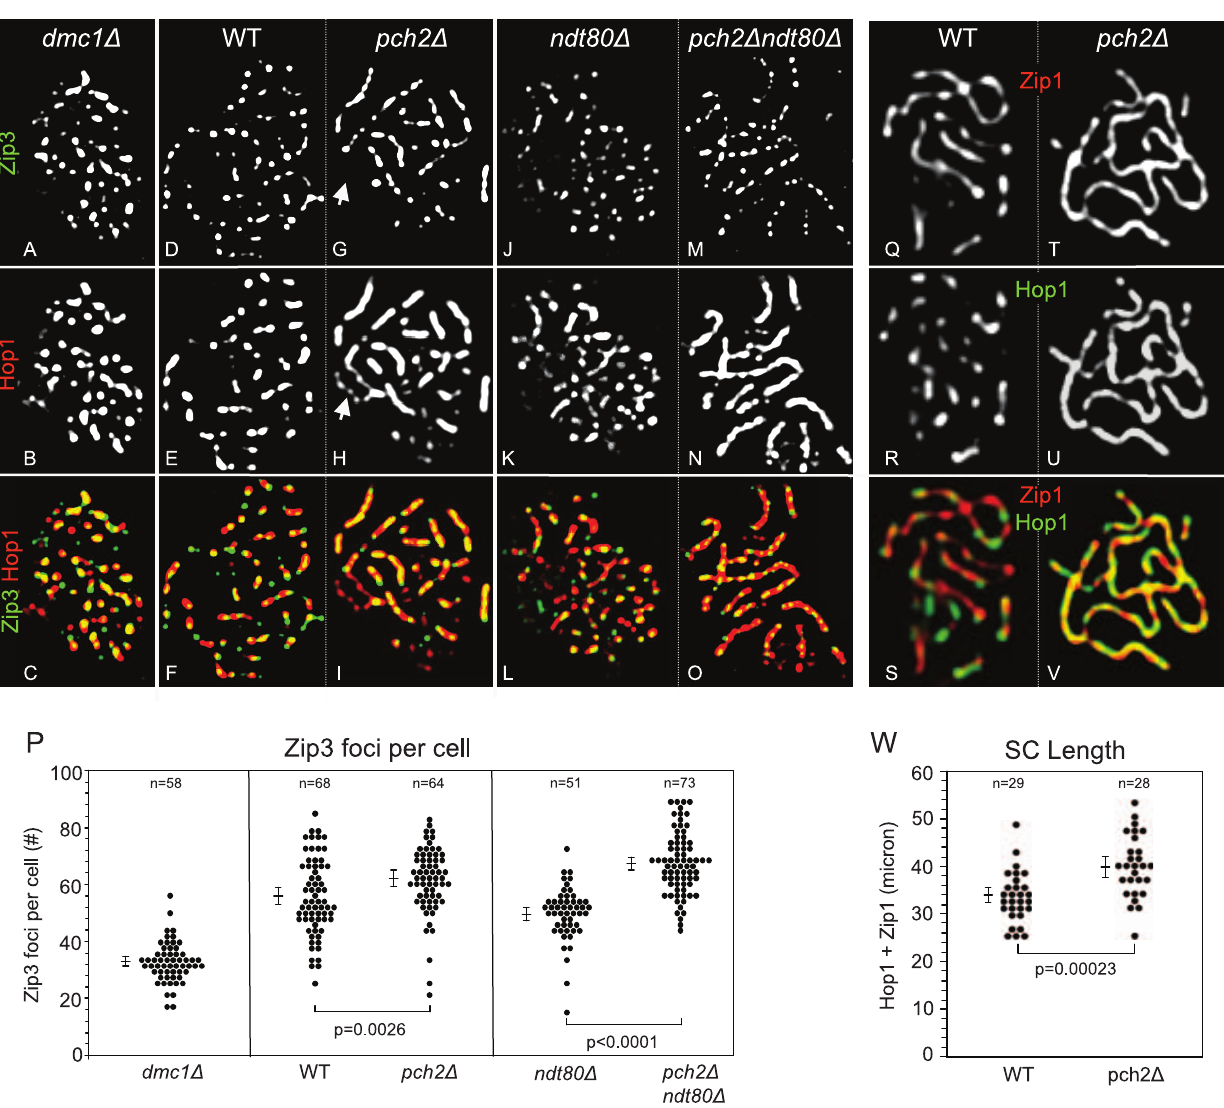
Figure 4. Effects of Dmc1, Pch2, and Ndt80 on Zip3 and Hop1 localization and SC length in WT and pch2 D . (A–P) Spread nuclei from dmc1 D (A–C), WT ( PCH2 ) (D–F), pch2 D (G–I), PCH2ndt80 D (J–L), pch2 D ndt80 D (M–O) were stained with antibodies against Hop1 and Zip3. Colors are indicated by the corresponding labels in the individual channels. Regions of overlap between Zip3 and Hop1 are indicated by yellow color. Note the patchy versus continuous Hop1 localization in WT (E,K) versus pch2 D (H,N). White arrow in (H) indicates the Hop1 stained nucleolus in pch2 D . (P) Numbers of Zip3 foci per nucleus determined in spread nuclei in dmc1 D (t=5 hrs), WT (t=7 hrs), pch2 D (t=7 hrs), PCH2ndt80 D (t=8 hrs), pch2 D ndt80 D (t=8 hrs), respectively. P-values are from two-sided Wilcoxon rank sum tests. Error bars represent 95% confidence intervals. (See also Figure S2 for analysis of Hop1 domains in WT and pch2 D .) (Q–V) Nuclei from WT (Q–S) or pch2 D (T–V) from parallel time courses were spread and stained with antibodies against Hop1 and Zip1. Note discontinuous staining of Hop1 and Zip1 in WT (Q,R) compared to continuous staining patterns for both proteins in pch2 D (T,U). (W) Twenty well-spread nuclei were selected and the combined contour length of Zip1 and Hop1 was determined in WT and pch2 D (see Materials and Methods). The average SC/axis length was 34 m m ( 6 1.8 m m C.I.) in WT and 40 m m ( 6 2.2 m m C.I.) in pch2 D , indicating a significant increase in pch2 D versus WT (p=0.00023; two-sided Wilcoxon rank sum test). Error bars represent 95% confidence intervals. Meiosis was induced at 33 u